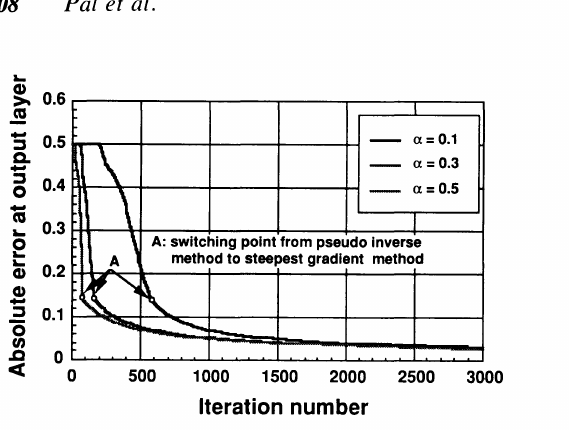
FIGURE 10 History of error for the combination of pseudoinverse and steepest gradient